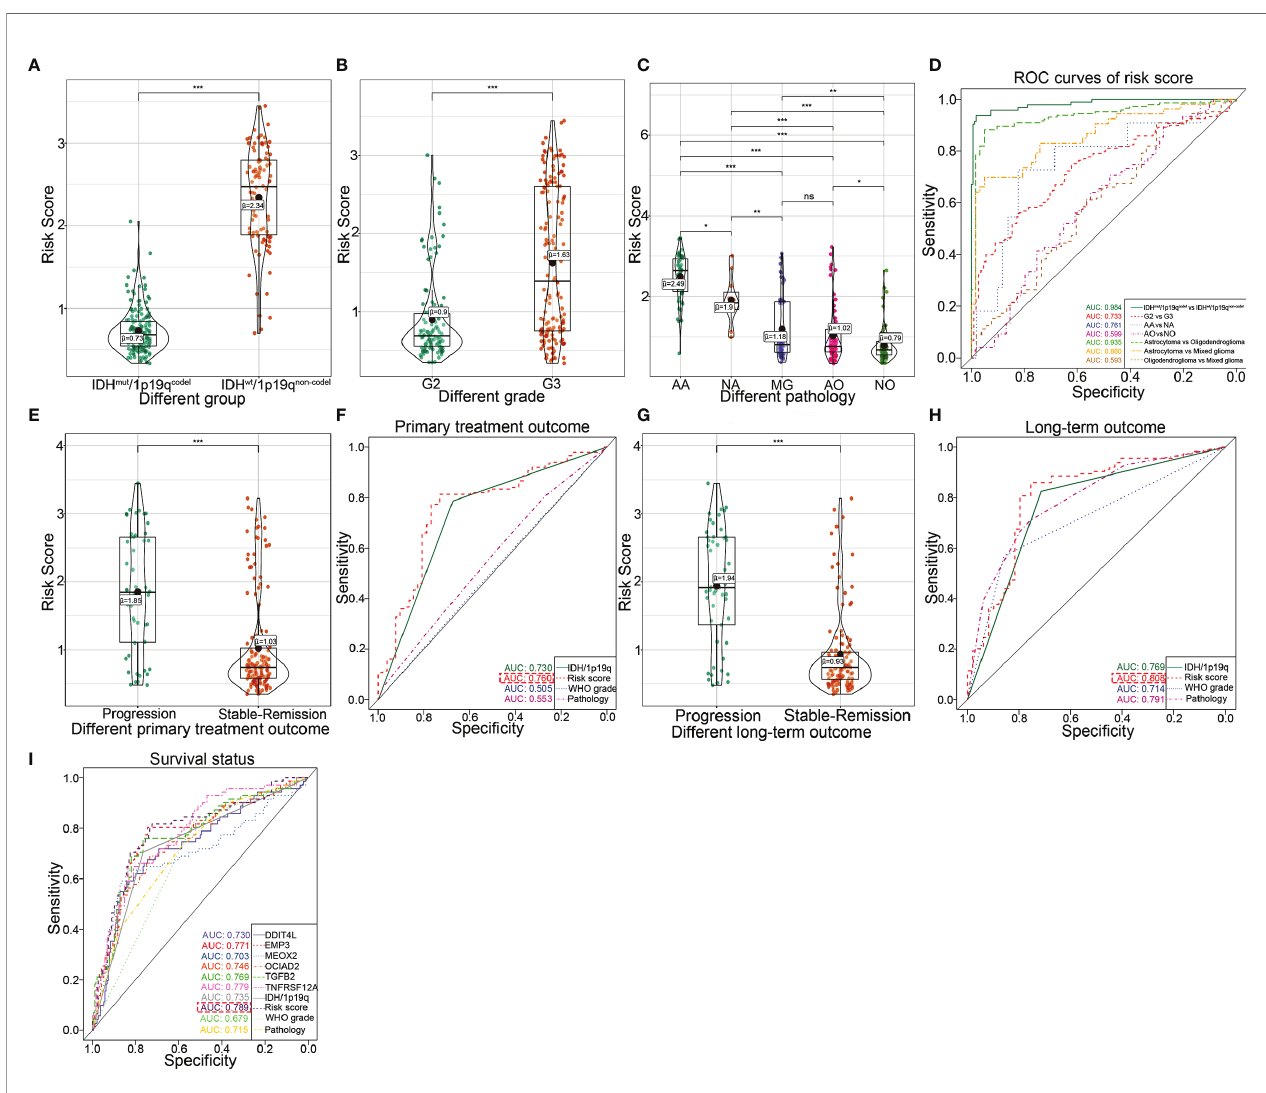
FIGURE 4 | Clarifying the ef fi ciency of the transcriptional risk score and indicating the pathological subtypes, therapy reaction, and patient survival in TCGA dataset. (A) The differential distribution of the transcriptional risk score in IDH wt /1p19q non-codel and IDH mut/ 1p19q codel based on TCGA cohort (*** p < 0.001, with t test). (B) The differential distribution of transcriptional risk score in G2 and G3 based on TCGA cohort (*** p < 0.001, with t test). (C) The differential distribution of transcriptional risk score in pathological subtypes based on TCGA cohort (*** p < 0.001, ** p < 0.01, * p < 0.05, and ns refer to not signi fi cance with t test). (D) The ROC curves analysis of transcriptional risk score for the IDH/1p19 group, pathological subtypes, and WHO grades based on TCGA cohort. (E) The differential distribution of the transcriptional risk score in different primary treatment outcomes based on TCGA cohort (*** p < 0.001, with t test). (F) The ROC curve analysis of primary treatment outcome using IDH/ 1p19q, transcriptional risk score, WHO grades, and pathological subtypes based on TCGA cohort, respectively. (G) The differential distribution of the transcriptional risk score in different long-term treatment outcomes based on TCGA cohort (*** p < 0.001, with t test). (H) The ROC curve analysis of long-term treatment outcome using IDH/1p19q, transcriptional risk score, WHO grades, and pathological subtypes based on TCGA cohort, respectively. (I) The ROC curve analysis of survival status using six DME genes, IDH/1p19q, transcriptional risk score, WHO grades, and pathological subtypes based on TCGA cohort,